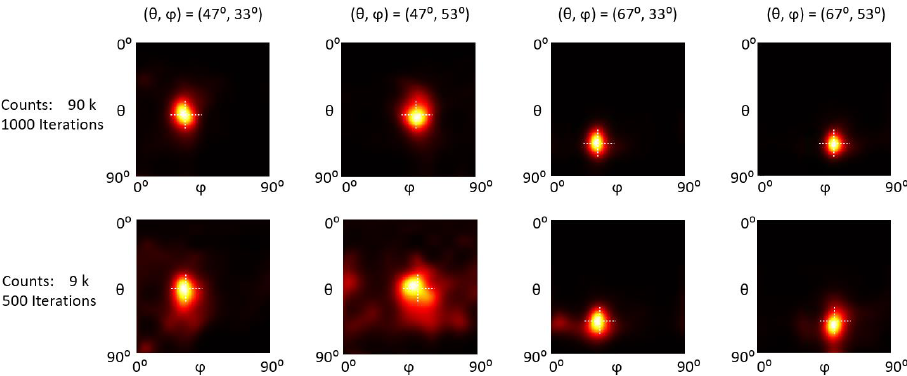
Figure 11. Reconstruction images of a 60 Co point sources at different positions with different count levels. The intersections of the dotted lines indicate the actual positions.